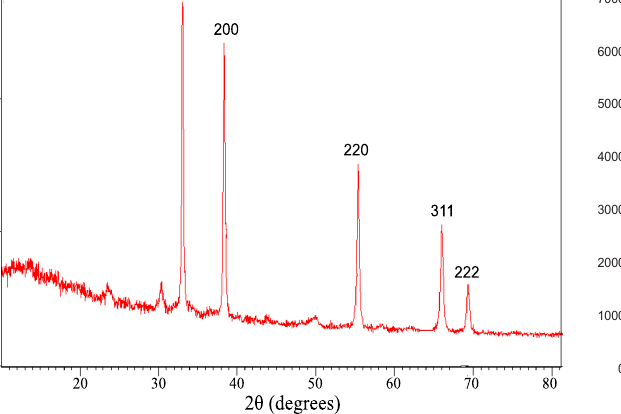
Fig. 2. XRD pattern of the synthesized CdO nanospheres.